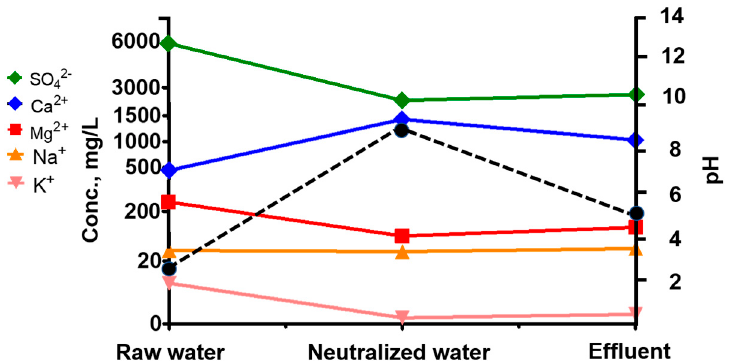
Figure 2. Changes in water quality at the various sampling points.